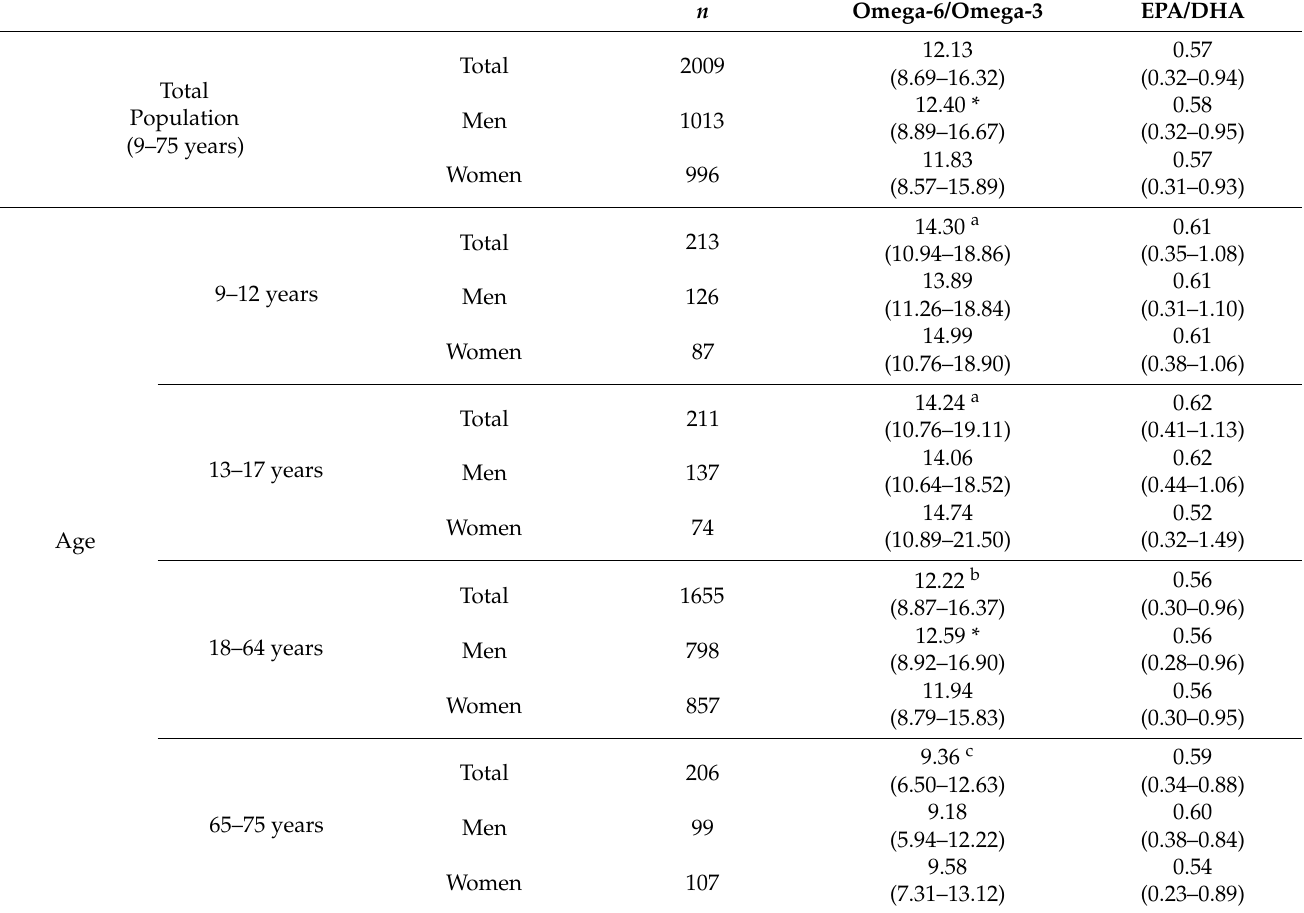
Table 5. Omega-6/Omega-3 and EPA/DHA dietary intake ratios among the ANIBES Study population.